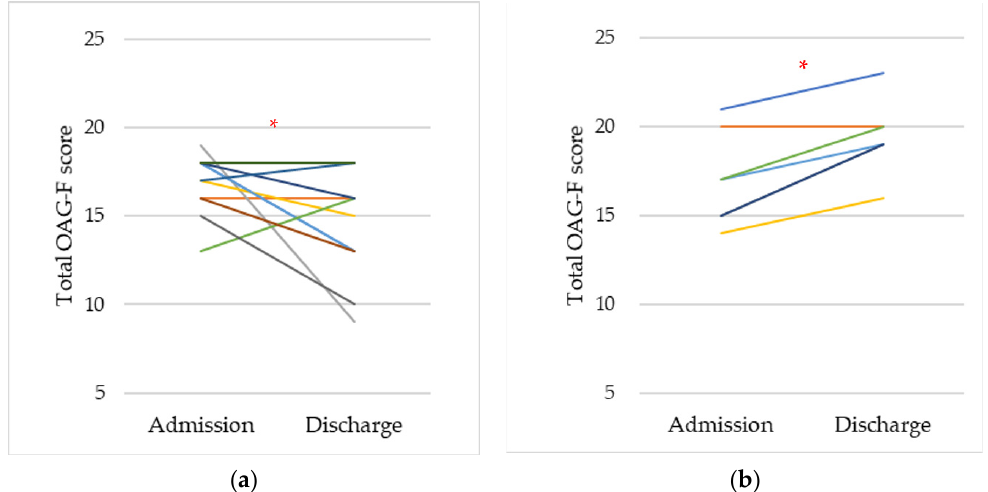
Figure 1. The change in the total OAG-F score between admission and discharge. ( a ) Survivors. ( b ) Non-survivors. * Asterisk indicates a statistically significant difference ( p < 0.05).